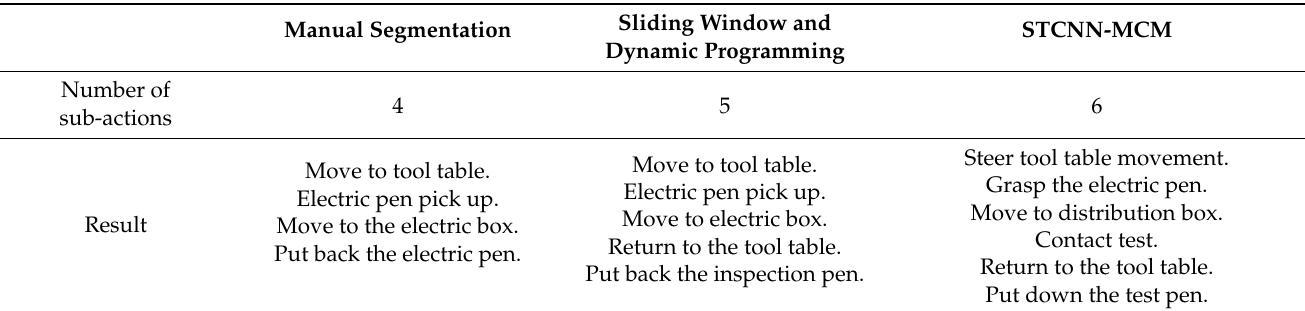
Table 2. Comparison of different segmentation